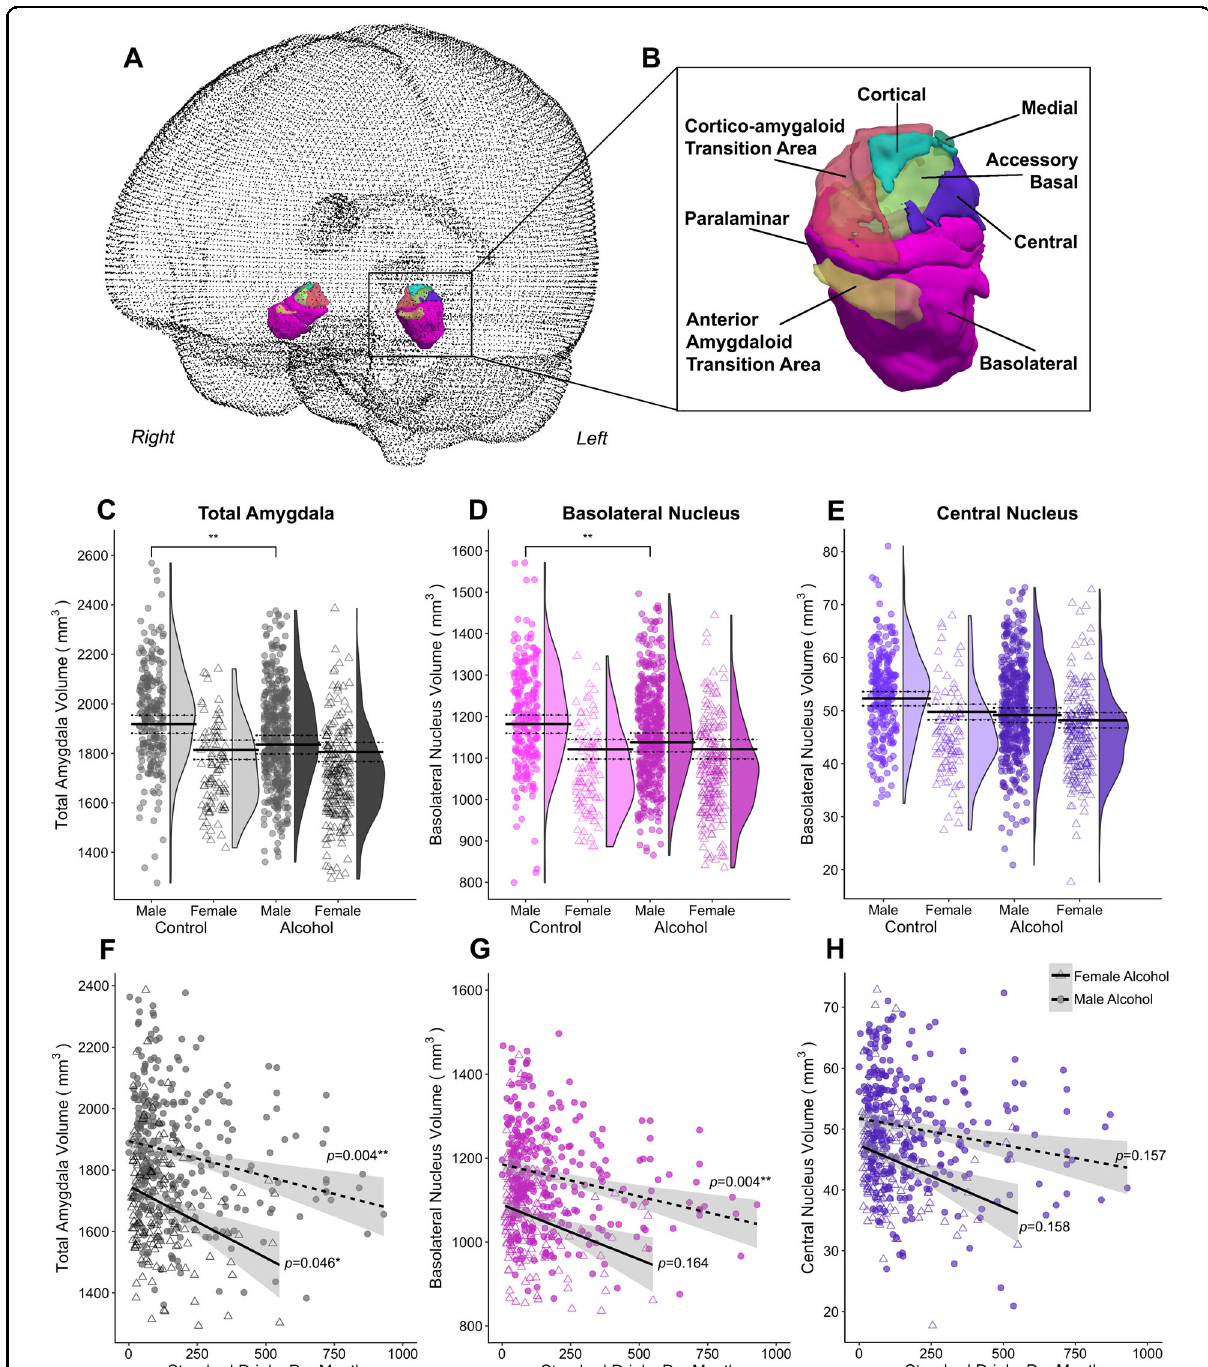
Fig. 1 Overview of group by sex effects on the volume of a-priori amygdala region and amygdala nuclei. A Overview of glass brain section showing 3D rendering and B close up of 3D renders of all amygdala nuclei from an example participant. Plots of the a priori amygdala regions, comprising C total amygdala in greyscale, D basolateral nuclei in pink, and E central nuclei in purple containing individual data points and the probability density of the data strati fi ed by group and sex (the group average of the estimated marginal means predicted by the models are indicated by the solid black line, with dotted lines indicating the standard error of the marginal means). The bottom panel shows regression plots for volume of the F total amygdala, G basolateral nuclei, and H central nuclei by alcohol use (standard alcohol drinks per month) in male and female alcohol-dependent participants, adjusted for intracranial volume, age, and education. Only the association in the male group for the total and basolateral amygdala remained signi fi cant after FDR correction. The left and right hemispheres for the nuclei have been collapsed. ** p (FDR) <